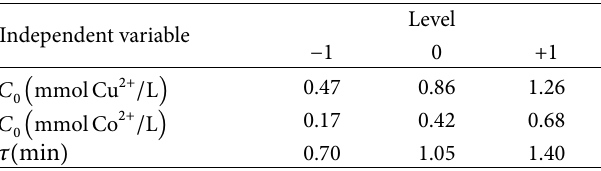
Table 1: Independent variables evaluated in the 2 2 experimental design and their levels for Cu 2+ and Co 2+ adsorption in a fixed-bed column using SBox as